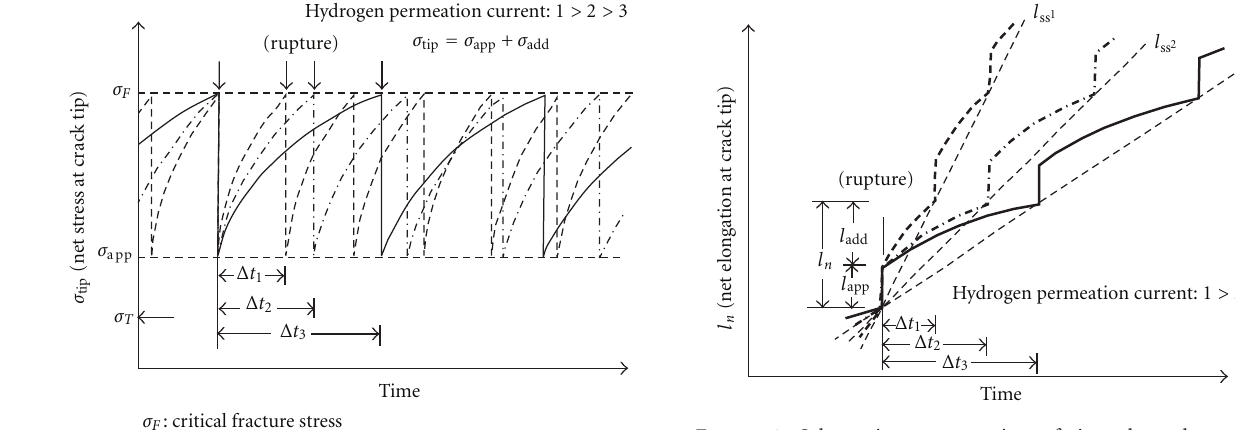
Figure 9: Schematic representation of time dependence of the net elongation ( l n ) during the film rupture-formation events at various hydrogen permeation currents under a constant applied stress condition, which corresponds to that in Figure